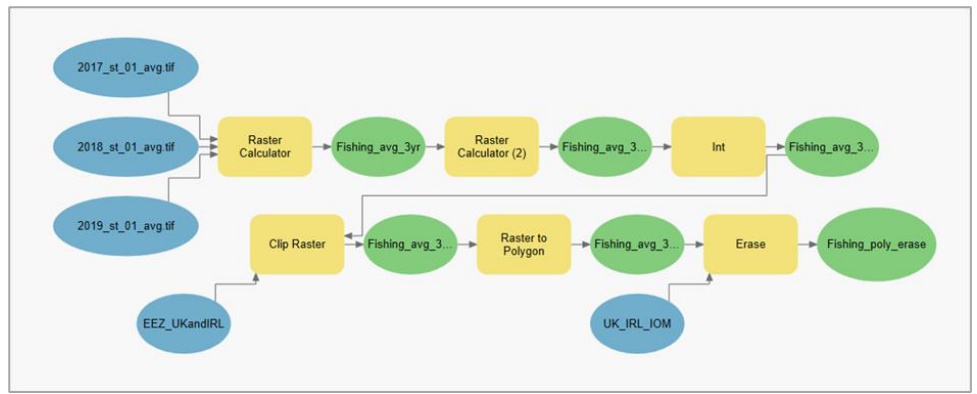
Figure 5. The model developed in ArcGIS Pro to process the AIS data for fishing vessels.